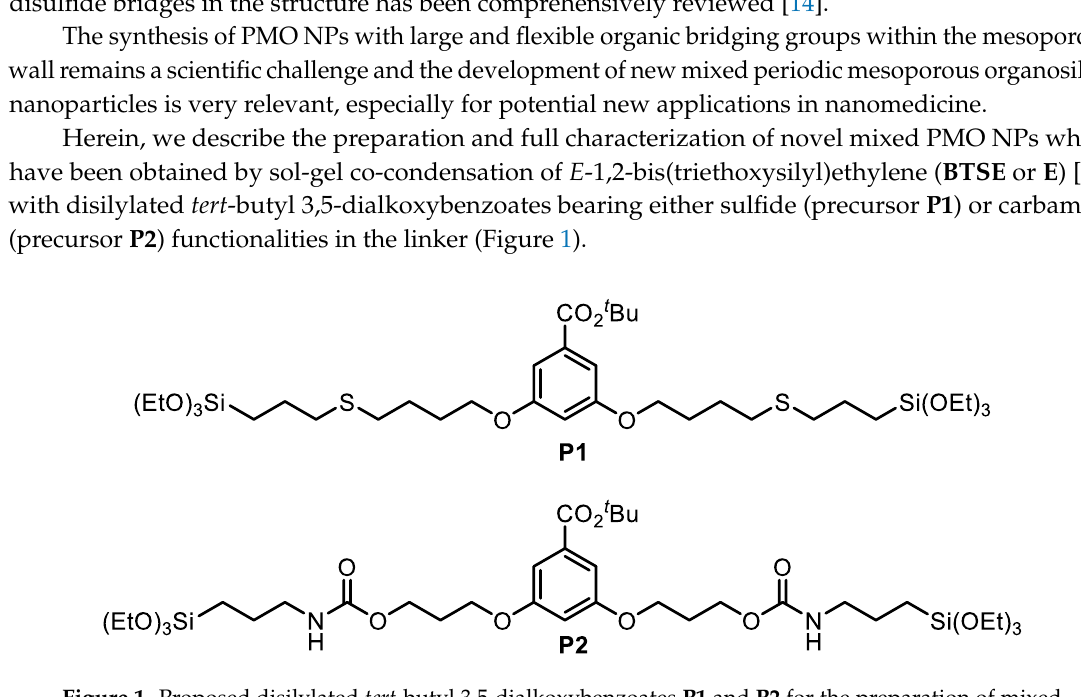
Figure 1. Proposed disilylated tert -butyl 3,5-dialkoxybenzoates P1 and P2 for the preparation of mixed PMO NPs.